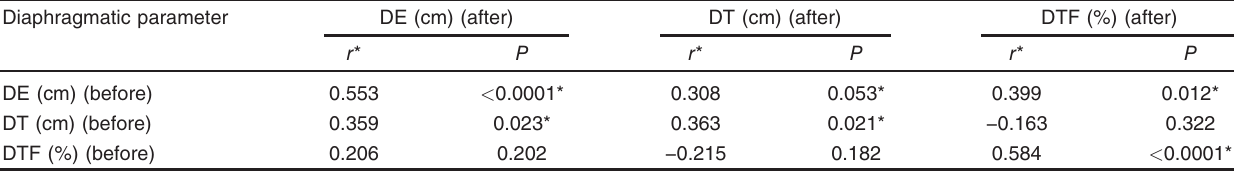
Table 2 Correlation between the ultrasound diaphragmatic parameters before and after weaning Diaphragmatic parameter